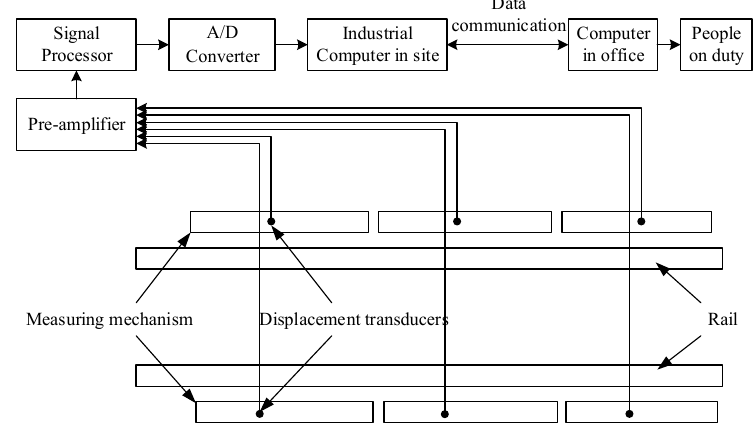
Figure 11. The architecture of the wheel flat detection system.